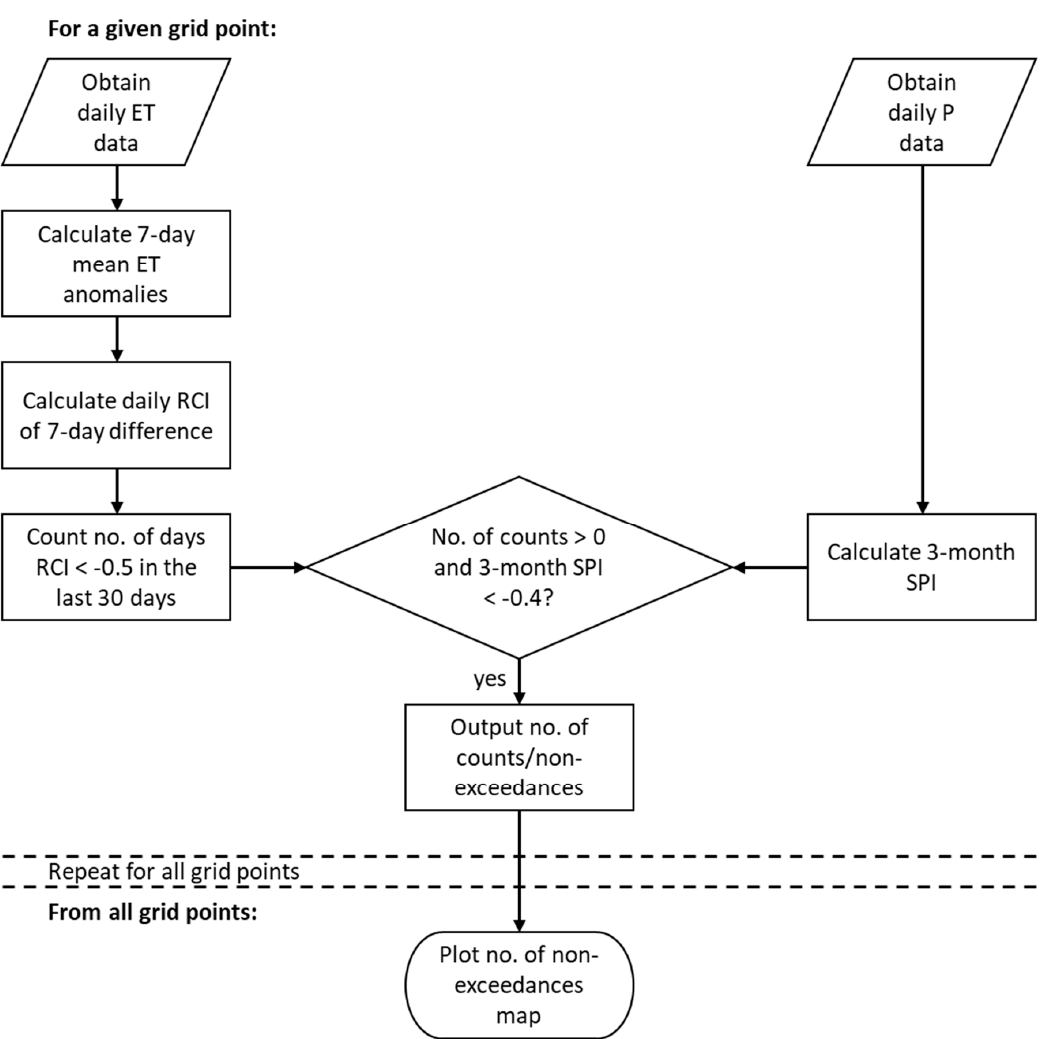
Figure 2. Schematic diagram for creating the potential flash drought development map.